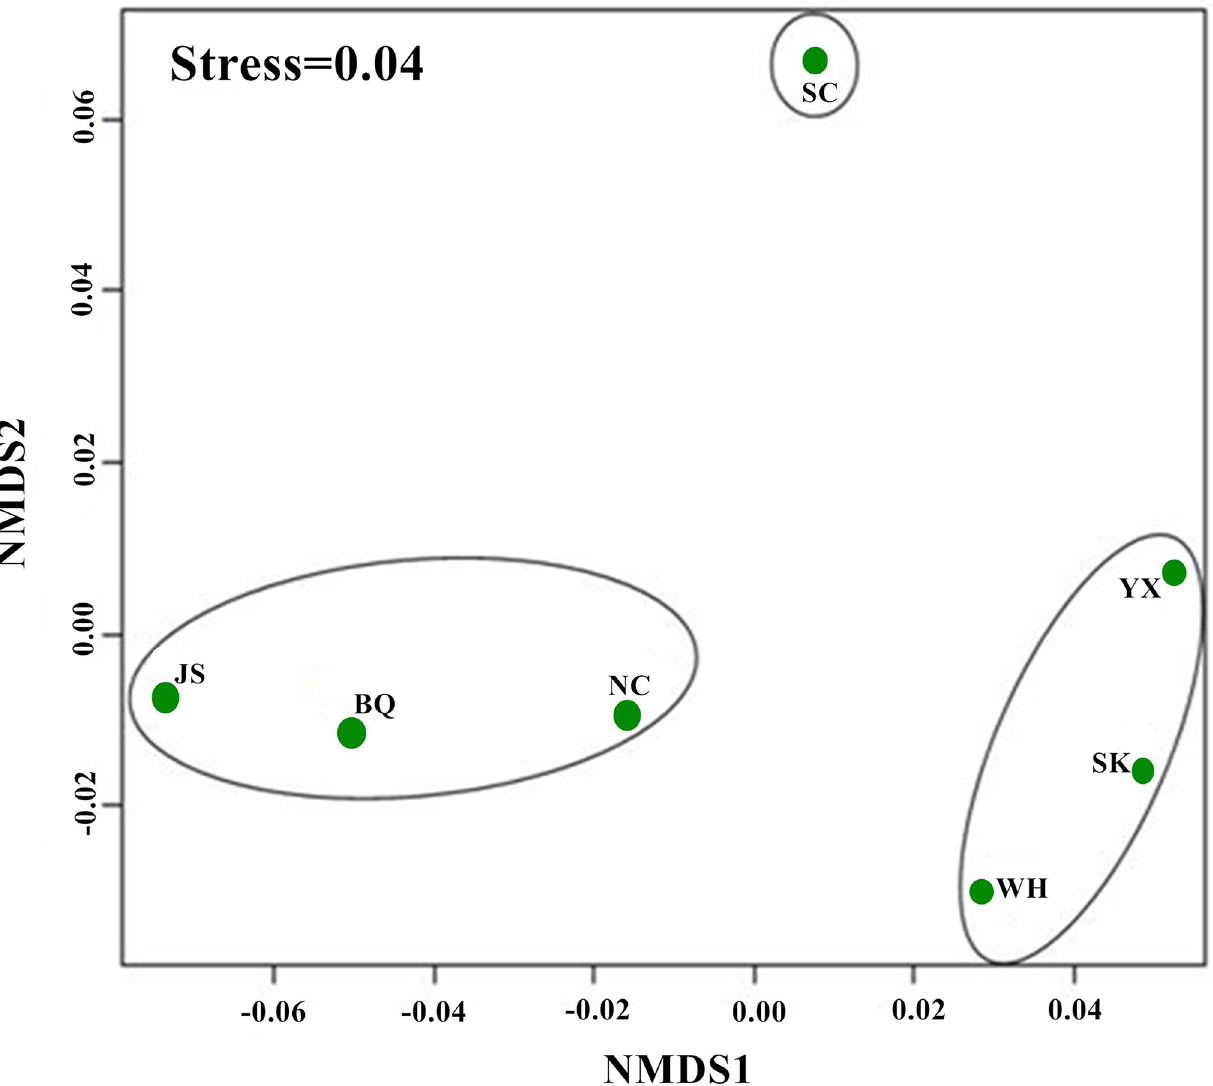
Fig 4. NMDS ordination of the fish community in the middle and lower reaches of the Ganjiang River. NC: Nanchang; BQ: Baqiu; JS: Jiangsha; WH: Wanhe; YX: Yanxi; SK: Shukou; and SC: